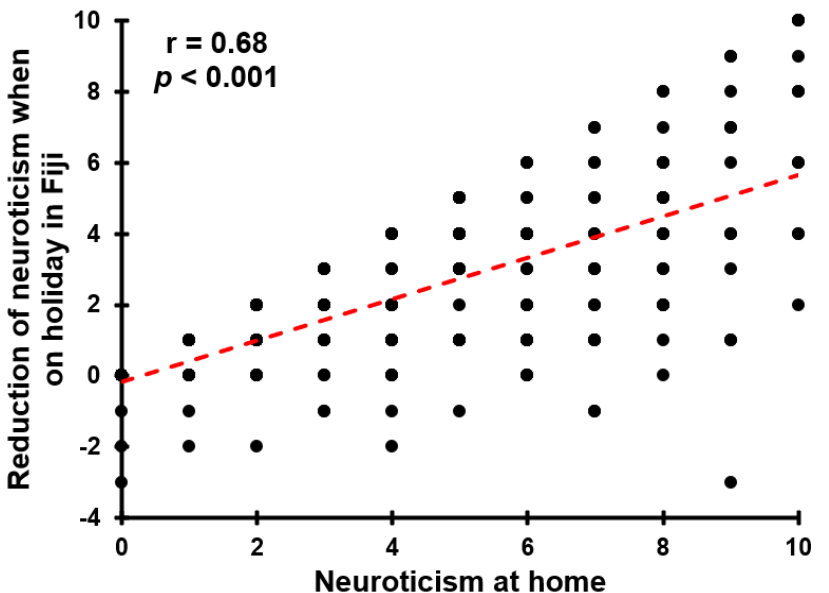
Figure 1. The impact of having a holiday on neuroticism. The Spearman’s correlation (red striped line) between neuroticism at home and the reduction in neuroticism when on holiday in Fiji (‘at home’—‘in Fiji’) is shown.